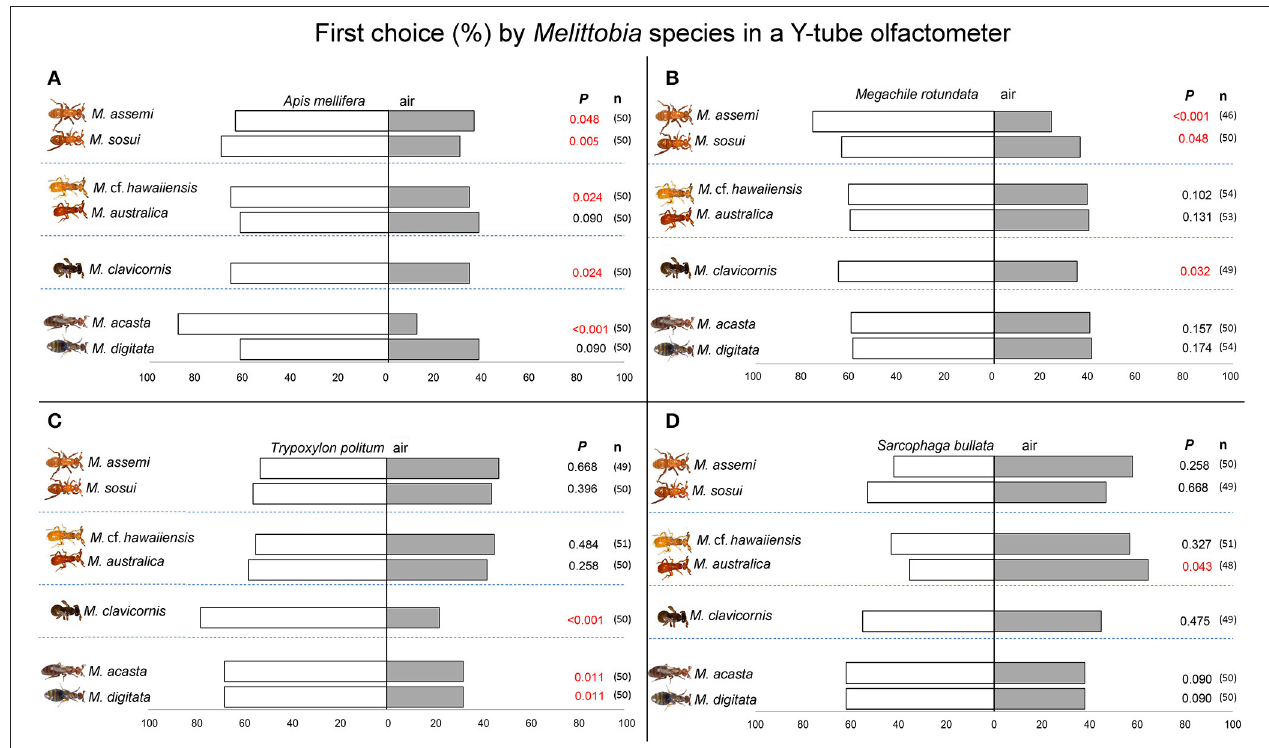
FIGURE 1 | Behavioral responses in a Y-tube olfactometer. Response of Melittobia species ( M. assemi, M. sosui, M. cf. hawaiiensis, M. australica, M. clavicornis, M. acasta, M. digitata ) to host-associated chemical cues from prepupae and pupae measured in terms of first choice. Bars indicate the percentage of wasps